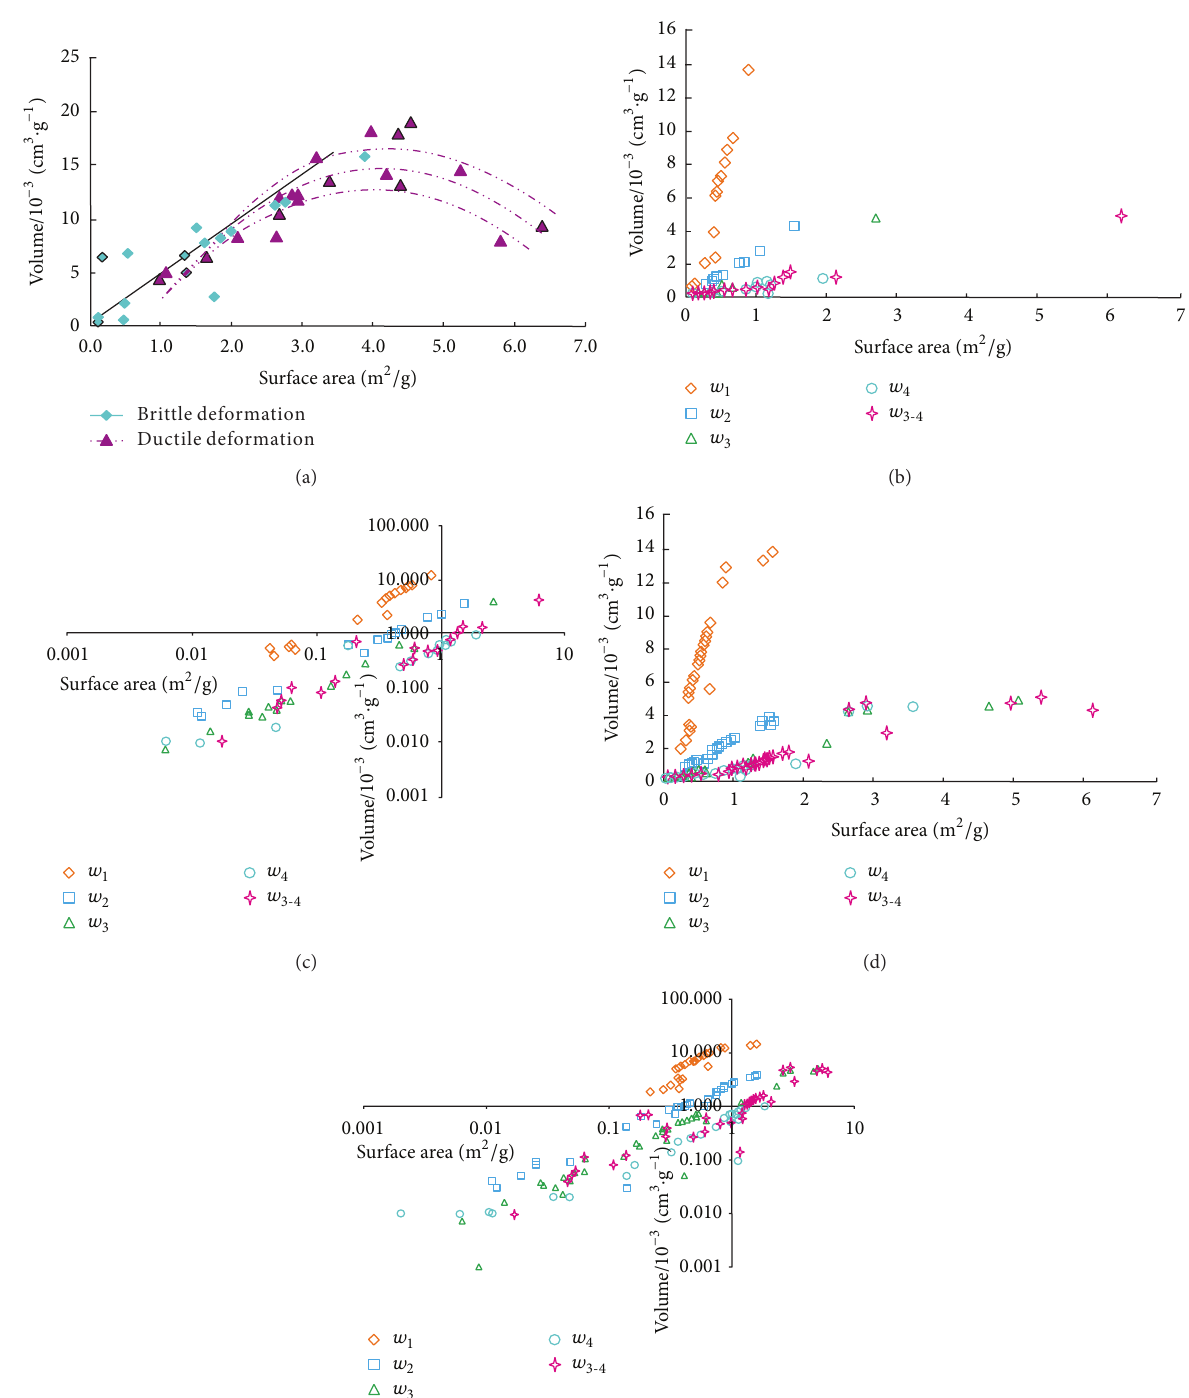
Figure 7: Relationship between 𝑆 and 𝑉 of deformed coal (a) in brittle and ductile deformed coal; (b, d) with different pore sizes in brittle and ductile deformed coals; (c, e) in log-log coordinate; 𝑤 1 – 𝑤 4 mean different pore sizes; 𝑤 3 The subscripts 1, 2, 3, and 4 are for mesopore (10 ∼ 100nm), micropore (5 ∼ 10nm), submicropore (2 ∼ 5 nm), and supermicropore ( < 2nm),